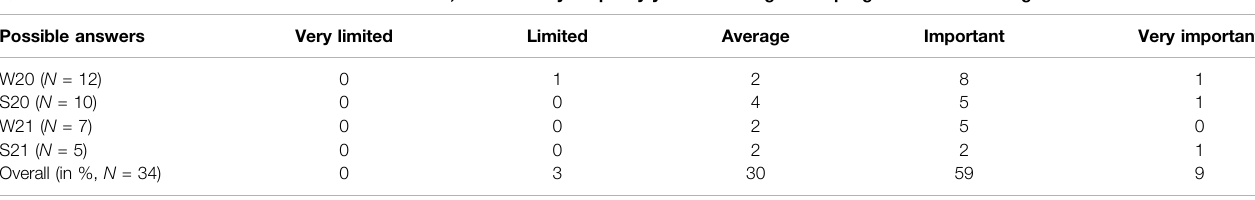
TABLE 2 | Results of the post-course survey over four teaching